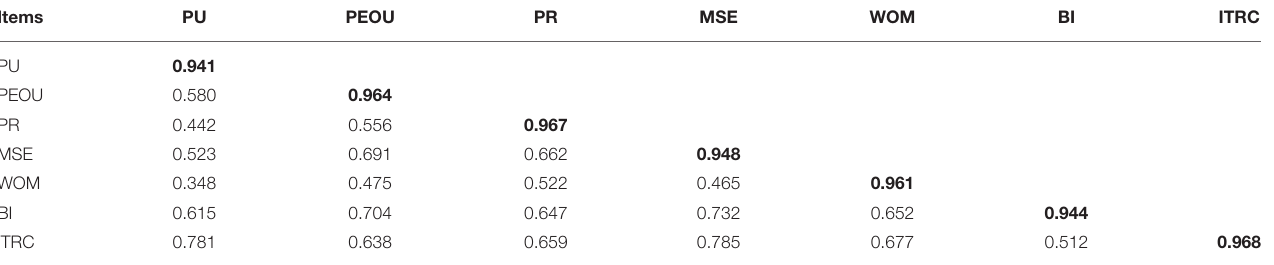
TABLE 6 | Discriminant